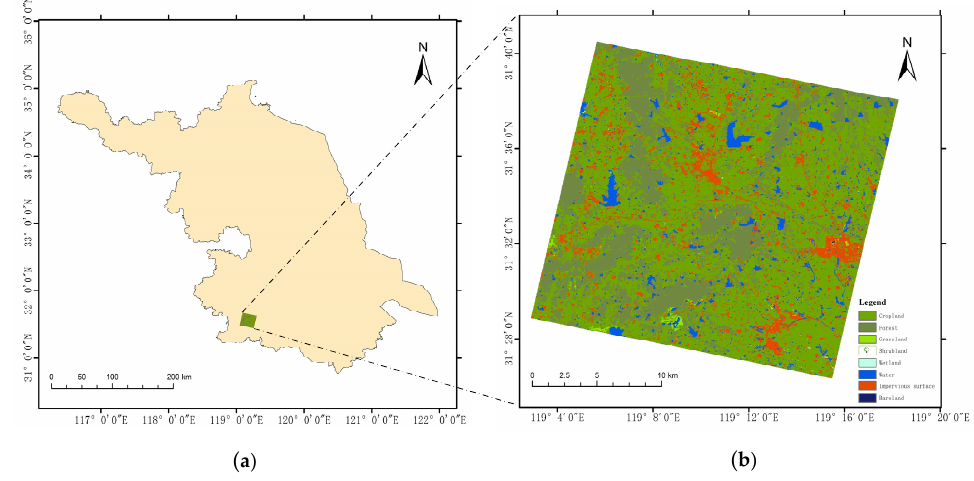
Figure 1. ( a ) Geographical location of the study area and ( b ) major land-cover types.